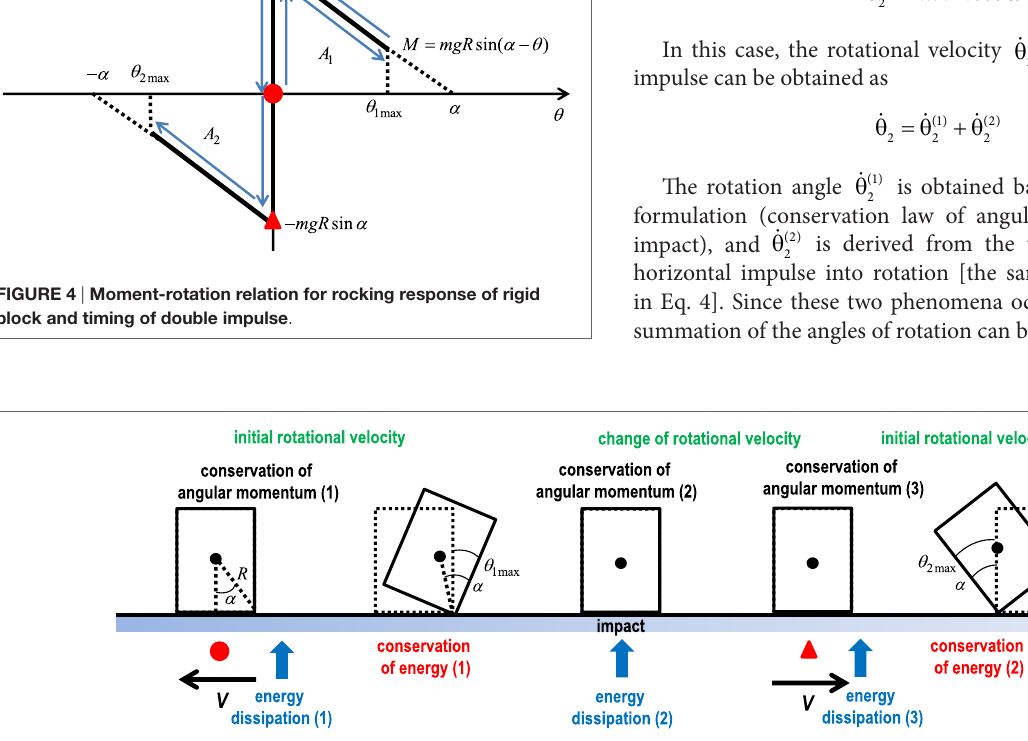
FigUre 5 | rocking response of rigid block and governing law (conservation of angular momentum, conservation of energy, and energy dissipation) .